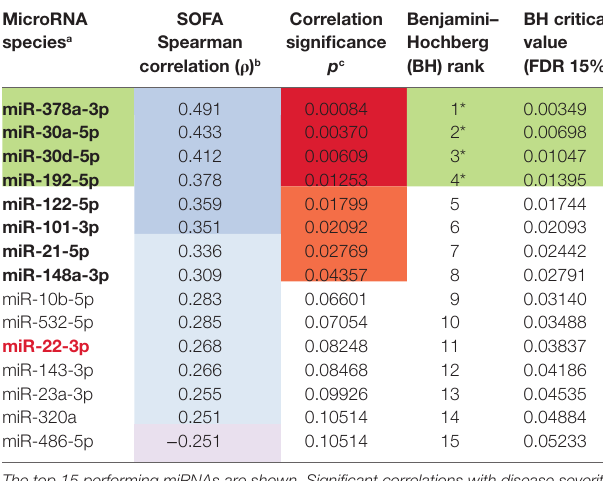
The top 15 performing miRNAs are shown. Significant correlations with disease severity are highlighted in bold black (SIRS) or red (sepsis). Refer to Table S4 in Supplementary Material for the full dataset. a Green-shadowed cells indicate miRNAs that passed the BH correction for multiple comparisons. b Blue- and violet-shadowed cells indicate miRNAs that returned positive and negative correlations ( ρ ≥ 0.2 or ρ ≤ − 0.2), respectively. c Brown- and red-shadowed cells indicate miRNAs that returned significant correlations (p ≤ 0.05) and additionally passed the correction for multiple comparisons, respectively.